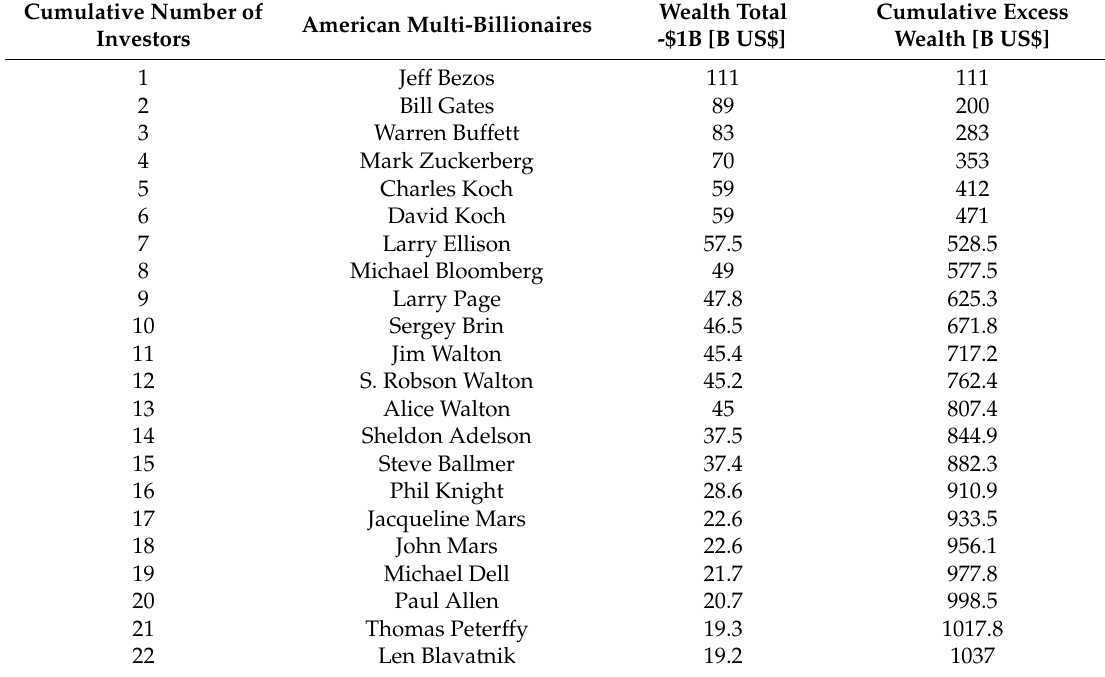
Table 1. Cumulative American multi-billionaires necessary to reach investment goals of complete replacement of all of the fossil fuel-based electricity generation in the U.S. with solar.